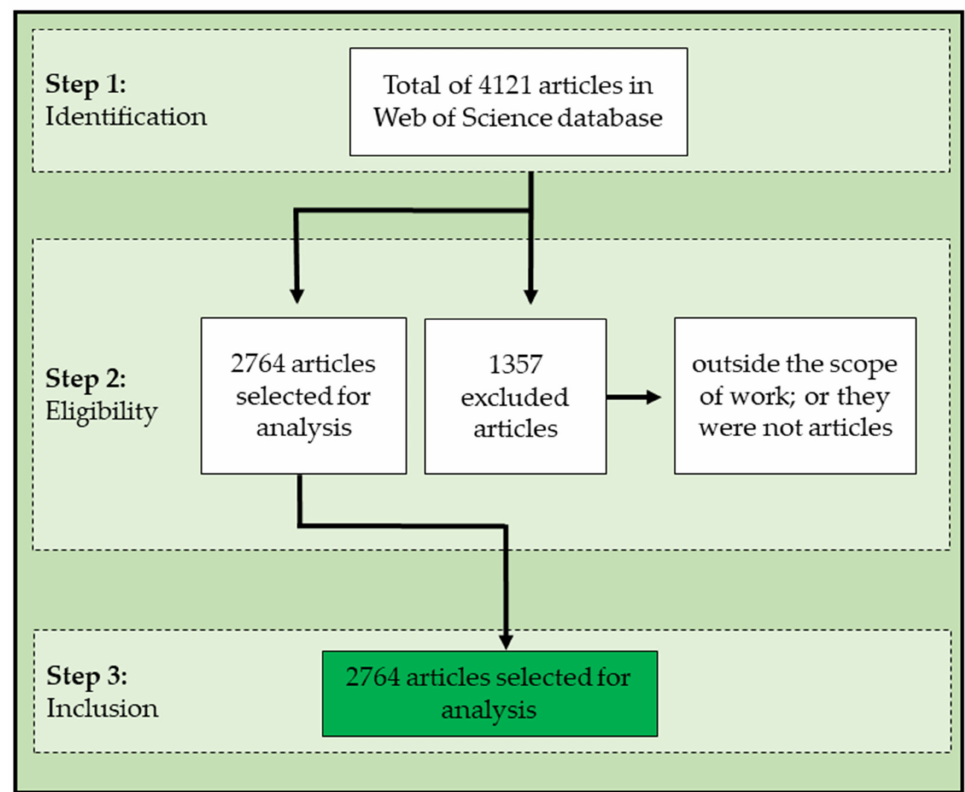
Figure 2. Flowchart of the steps used to extract the final number of articles about Odonata from the Web of Science database, from 2012 to 2021.